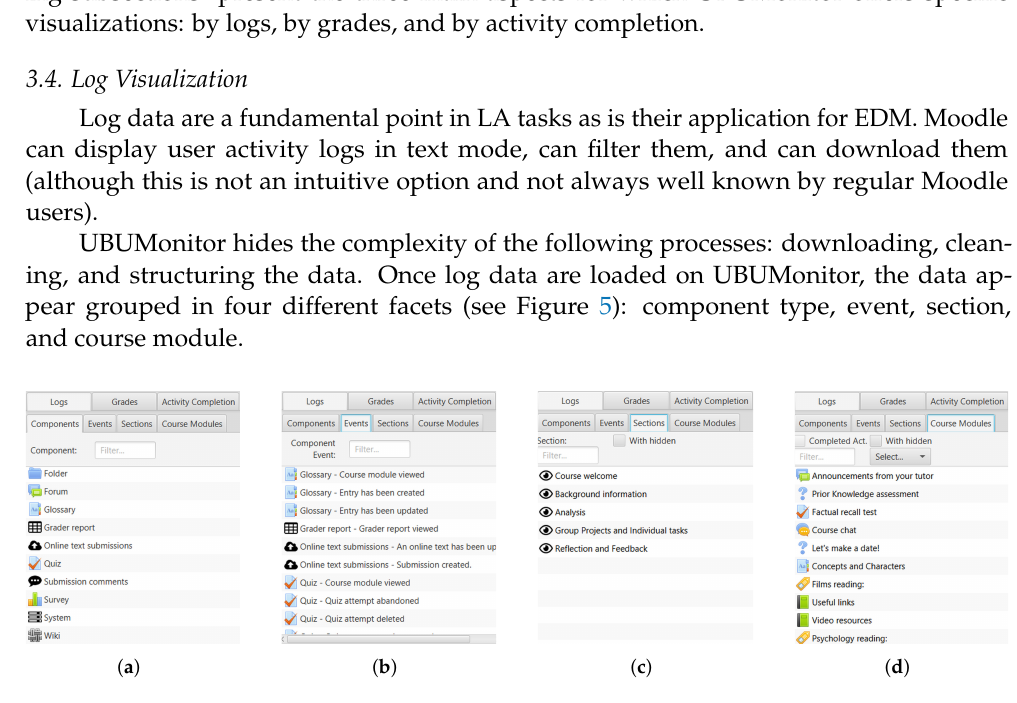
Figure 5. Tabbed panels of logs on UBUMonitor. ( a ) Components. ( b ) Events. ( c ) Sections. ( d ) Course